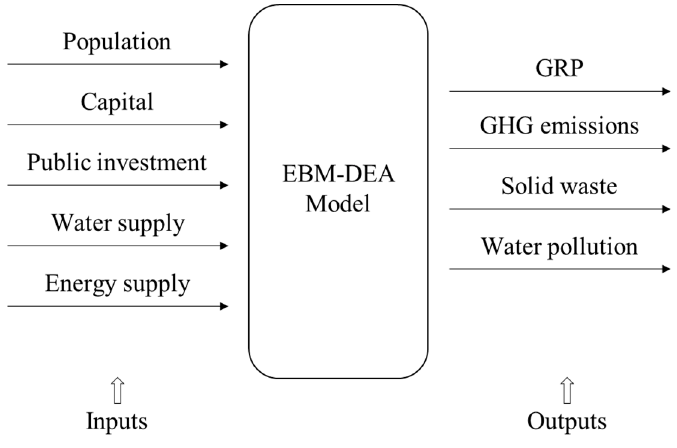
Figure 1. The framework of the EBM models. Table 1. Units and explanations of the variables used in the models.